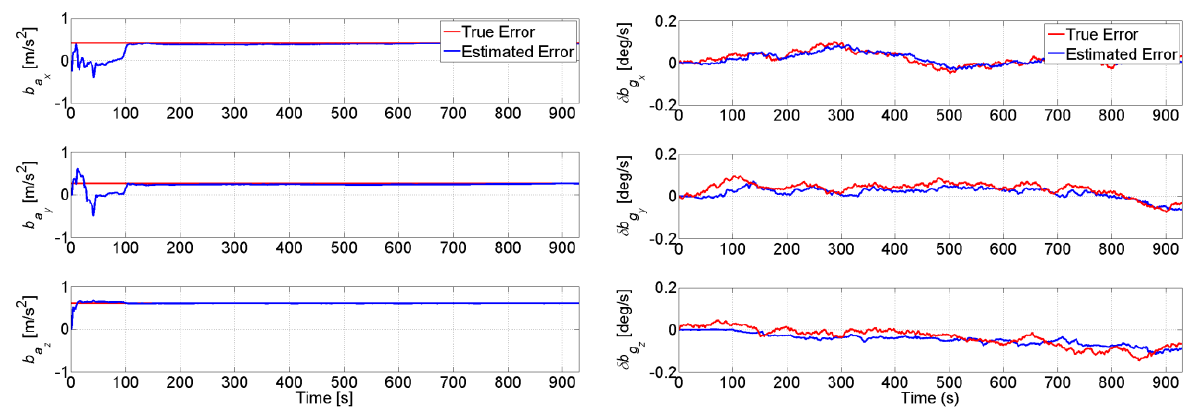
Figure 14. Estimated accelerometer turn-on to turn-on constant bias ( left ) and gyroscope bias drift ( right